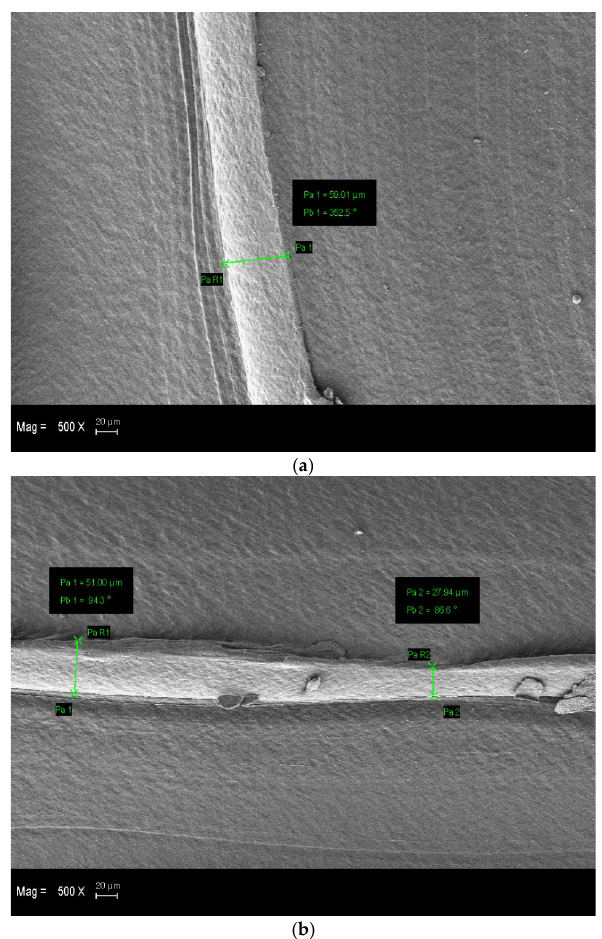
Figure 9. Diameter measurement for the printing fibres of ( a ) non-cured and ( b ) 30 min post-UV- cured PLA specimens produced at 190 °C . PLA specimens produced at 190 ◦